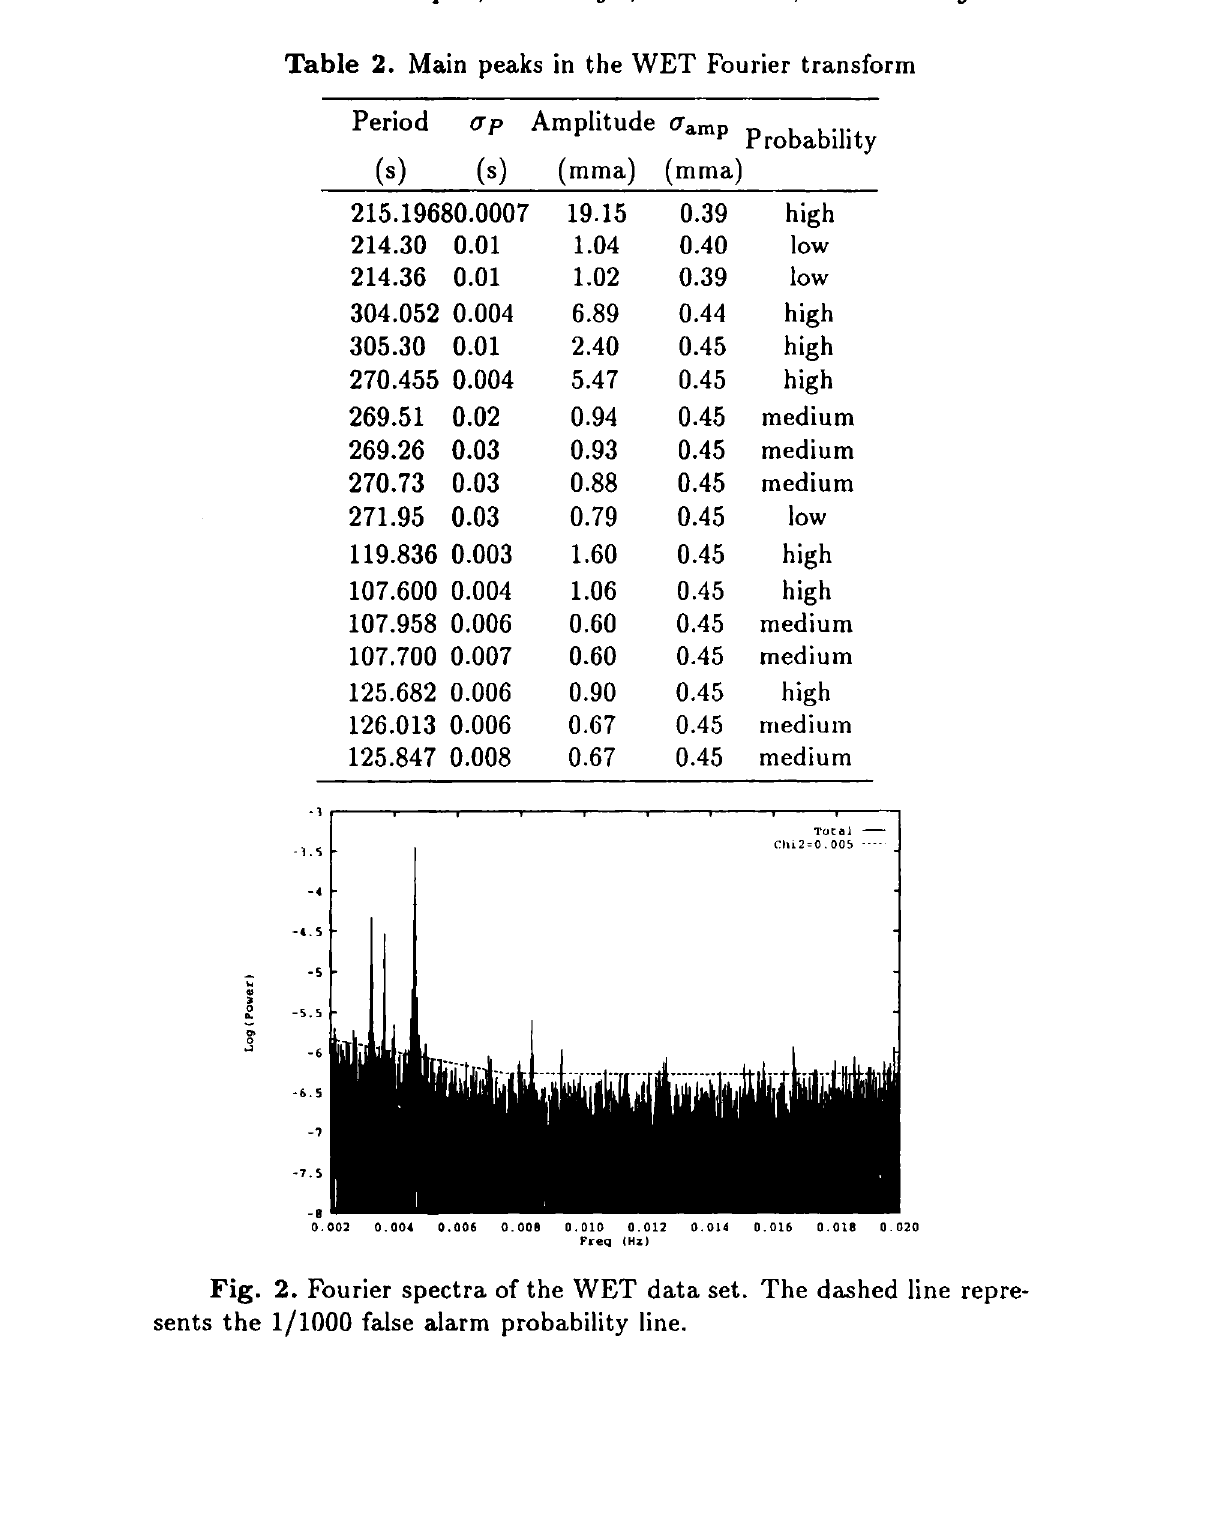
Table 2. Main peaks in the WET Fourier transform